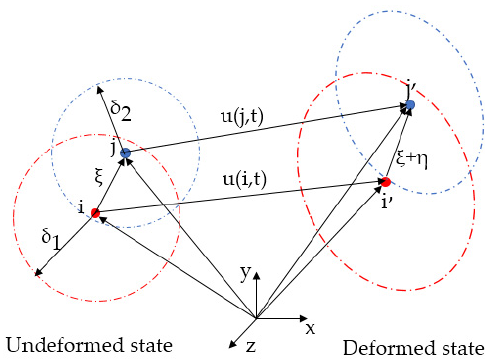
Figure 1. Interaction between material points.